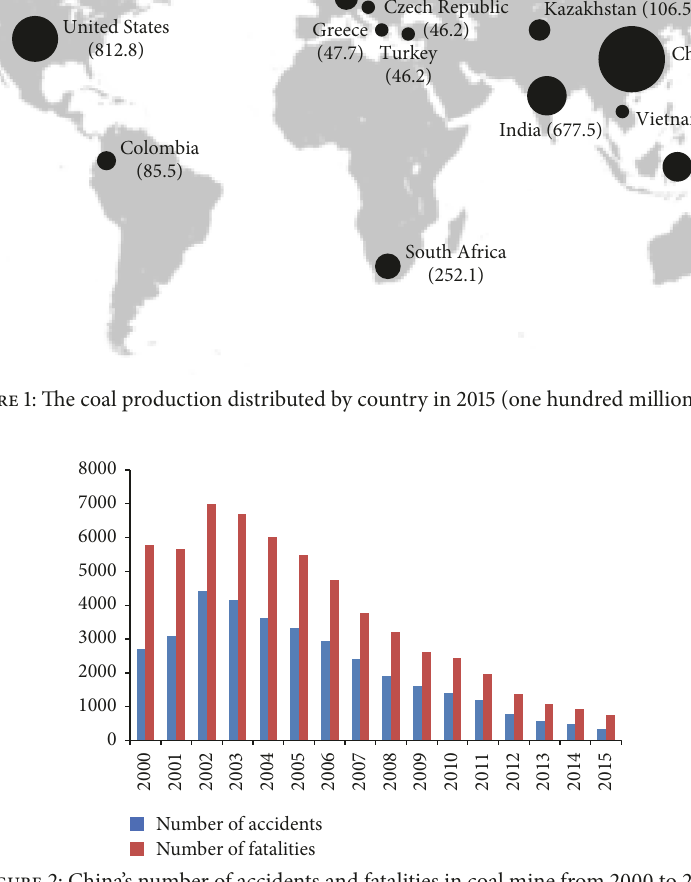
Figure 2: China’s number of accidents and fatalities in coal mine from 2000 to